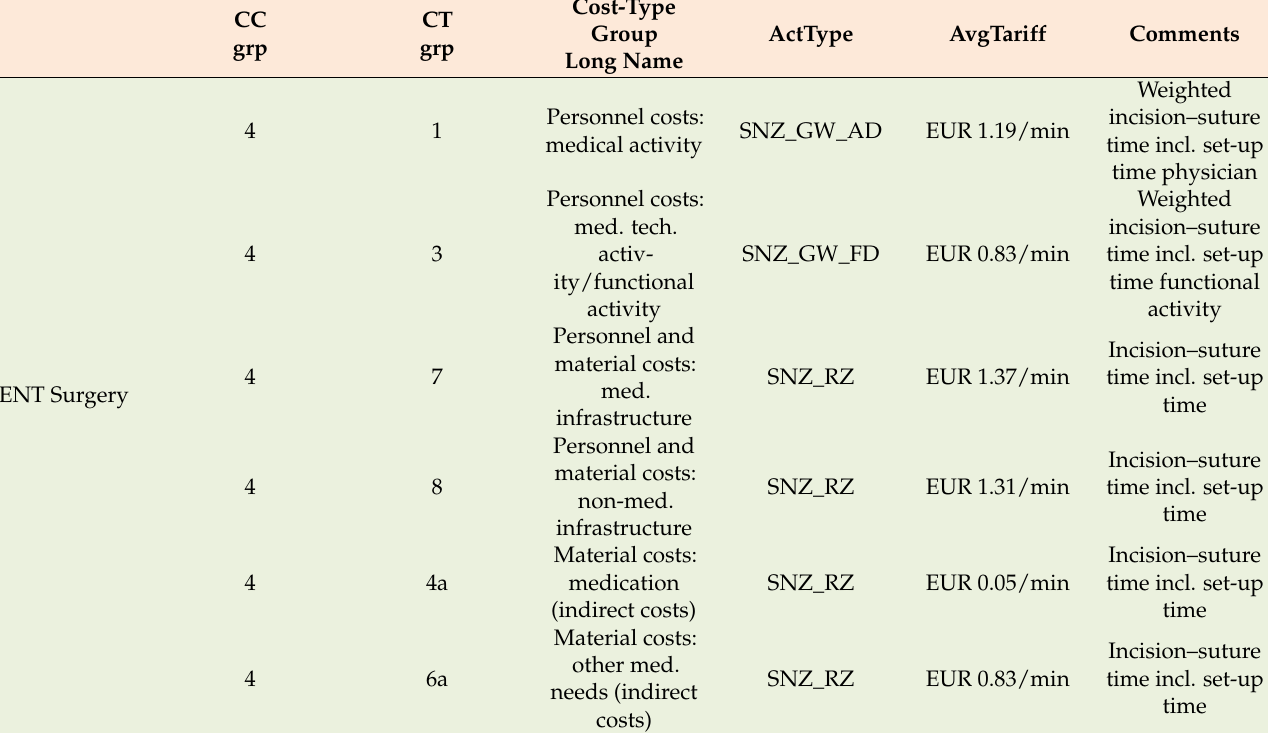
Table 4. Cost rates for ENT surgery and anesthesia in the ENT clinic. (CC grp: cost center group; CT grp: cost-type group; ActType: activity type; Avg Tariff: average tariff; IST: incision-suture time; Wt: weighted; MA: medical activity; FA: functional activity; SUT: set-up time; ANA: